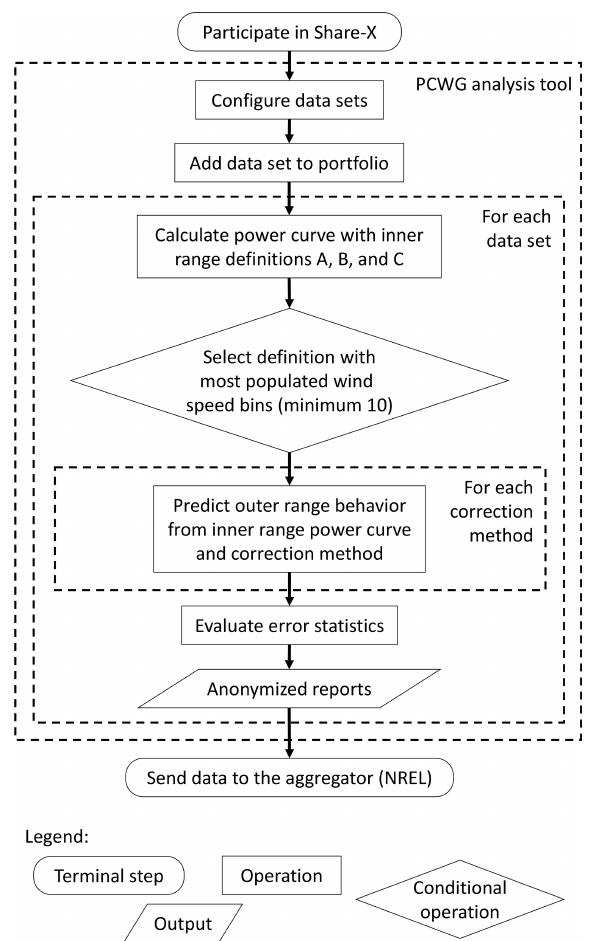
Figure 2. Workflow of the Share-3